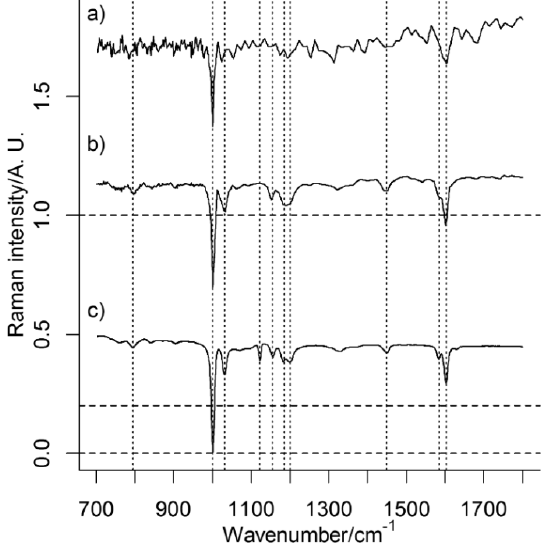
Figure 2. Loadings for PC2 for ( a ) the 500 nm image; and ( b ) the 100 nm image. ( c ) Reference spectrum of PS multiplied by −1. Raman bands assigned to PS are marked with dashed lines. An intensity offset have been added to the spectra.